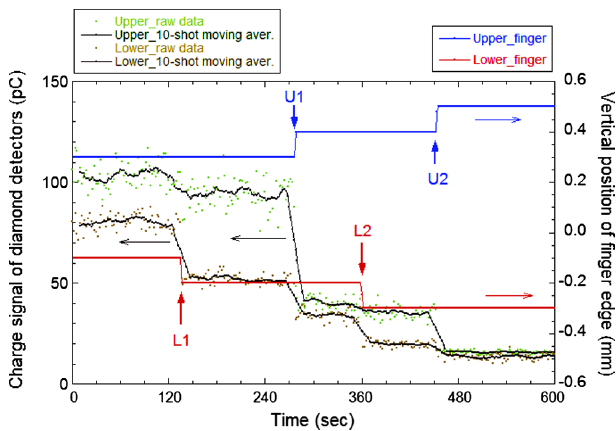
FIG. 20. Behavior of charge signal of diamond-based detectors when the vertical position of the finger edge is changed. The gap was varied from 0.4 to 0.8 mm.